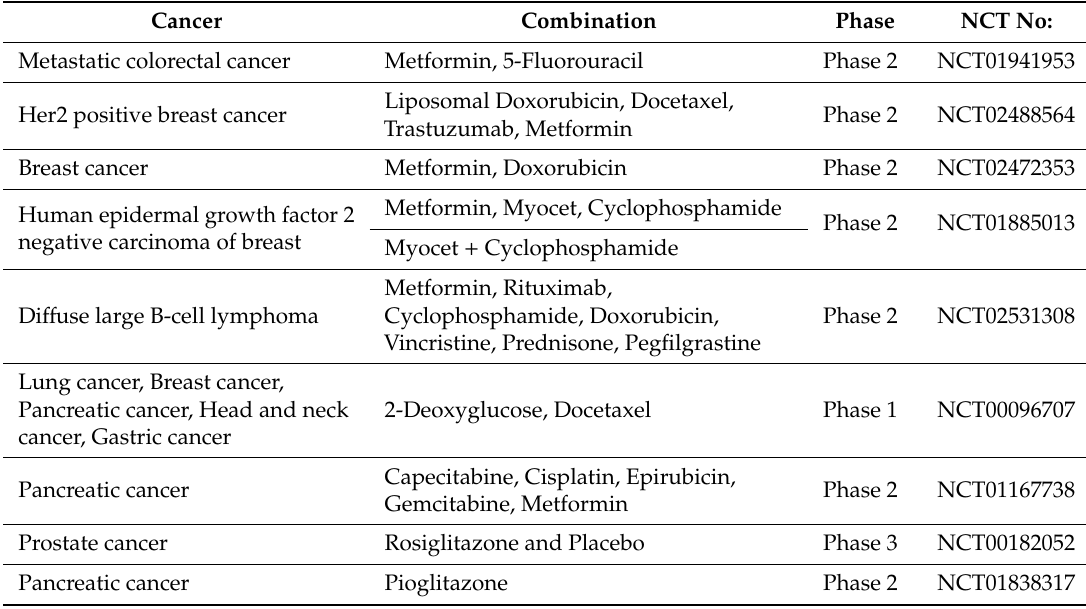
Table 2. Anti-hyperglycemic / anti-diabetic drugs alone or in combination for cancer therapy. Cancer Combination Phase NCT No: Metastatic colorectal cancer Metformin, 5-Fluorouracil Phase 2 NCT01941953 Liposomal Doxorubicin, Docetaxel, Phase